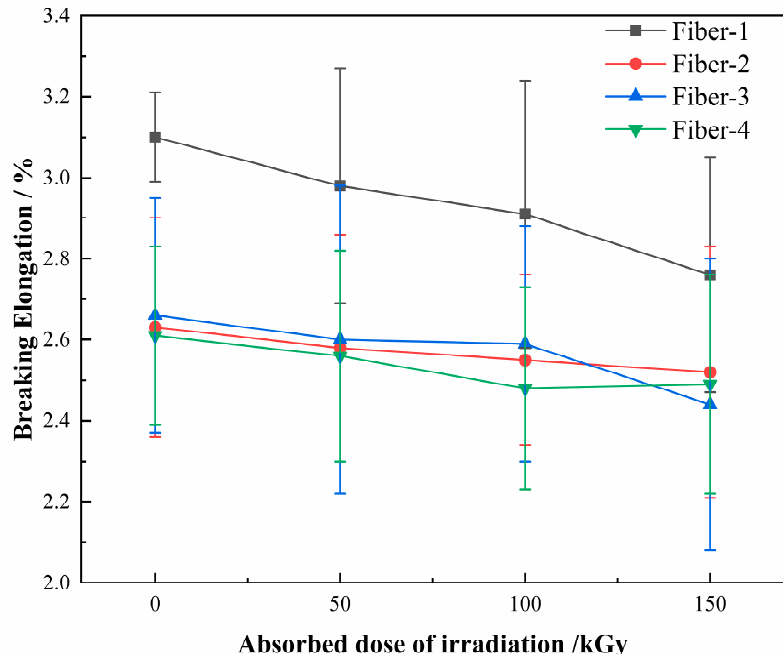
Figure 14. Variation of fiber elongation at break with the gamma irradiation absorbed dose.